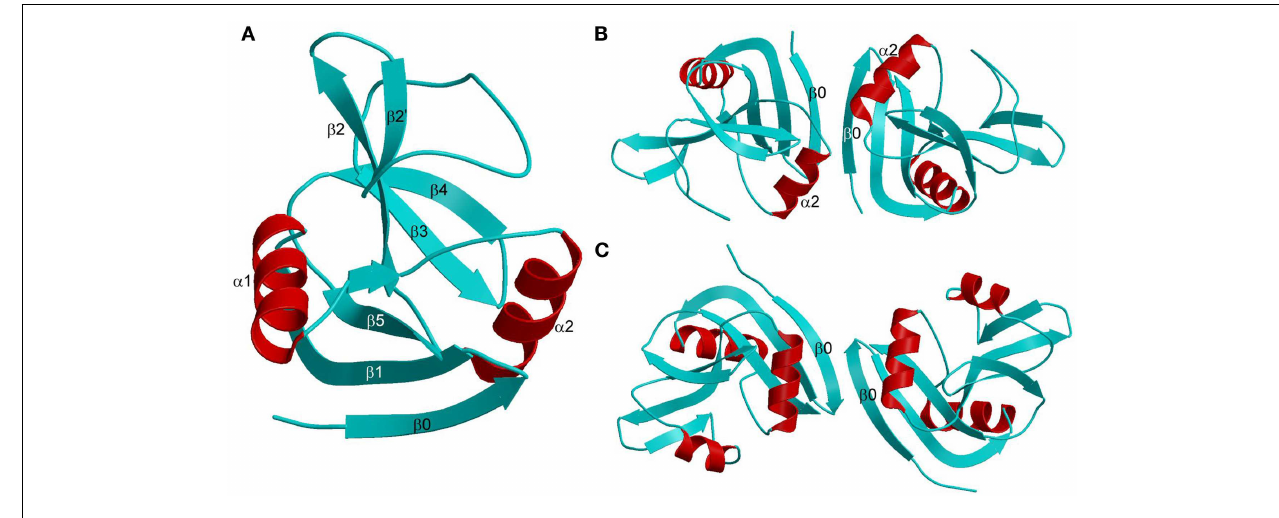
elements that participate in formation of the dimer interface are labeled.The α 2 helices are juxtaposed. (C) Structure of the “open” Ly49C homodimer (3C8J).The α 2 helices do not make contact across the dimer